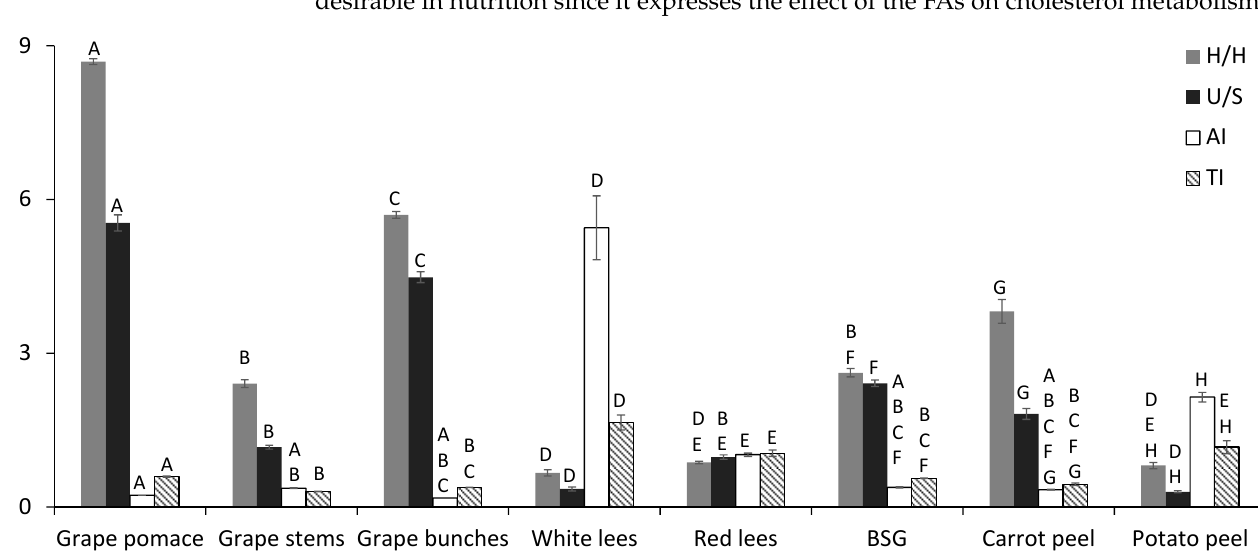
Figure 1. Hypo- and hypercholesterolemic FAs ratio (H/H), unsaturation ratio (U/S), atherogenicity (AI), and thrombo- genicity (TI) indexes of agri-food by-products. Different letters in a bar represent statistically significant differences among agri-food by-products by one-way ANOVA and Tukey’s multiple test at p < 0.05. The AI values ranged from 0.11 (grape pomace) to 5.45 (white lees), whereas the TI